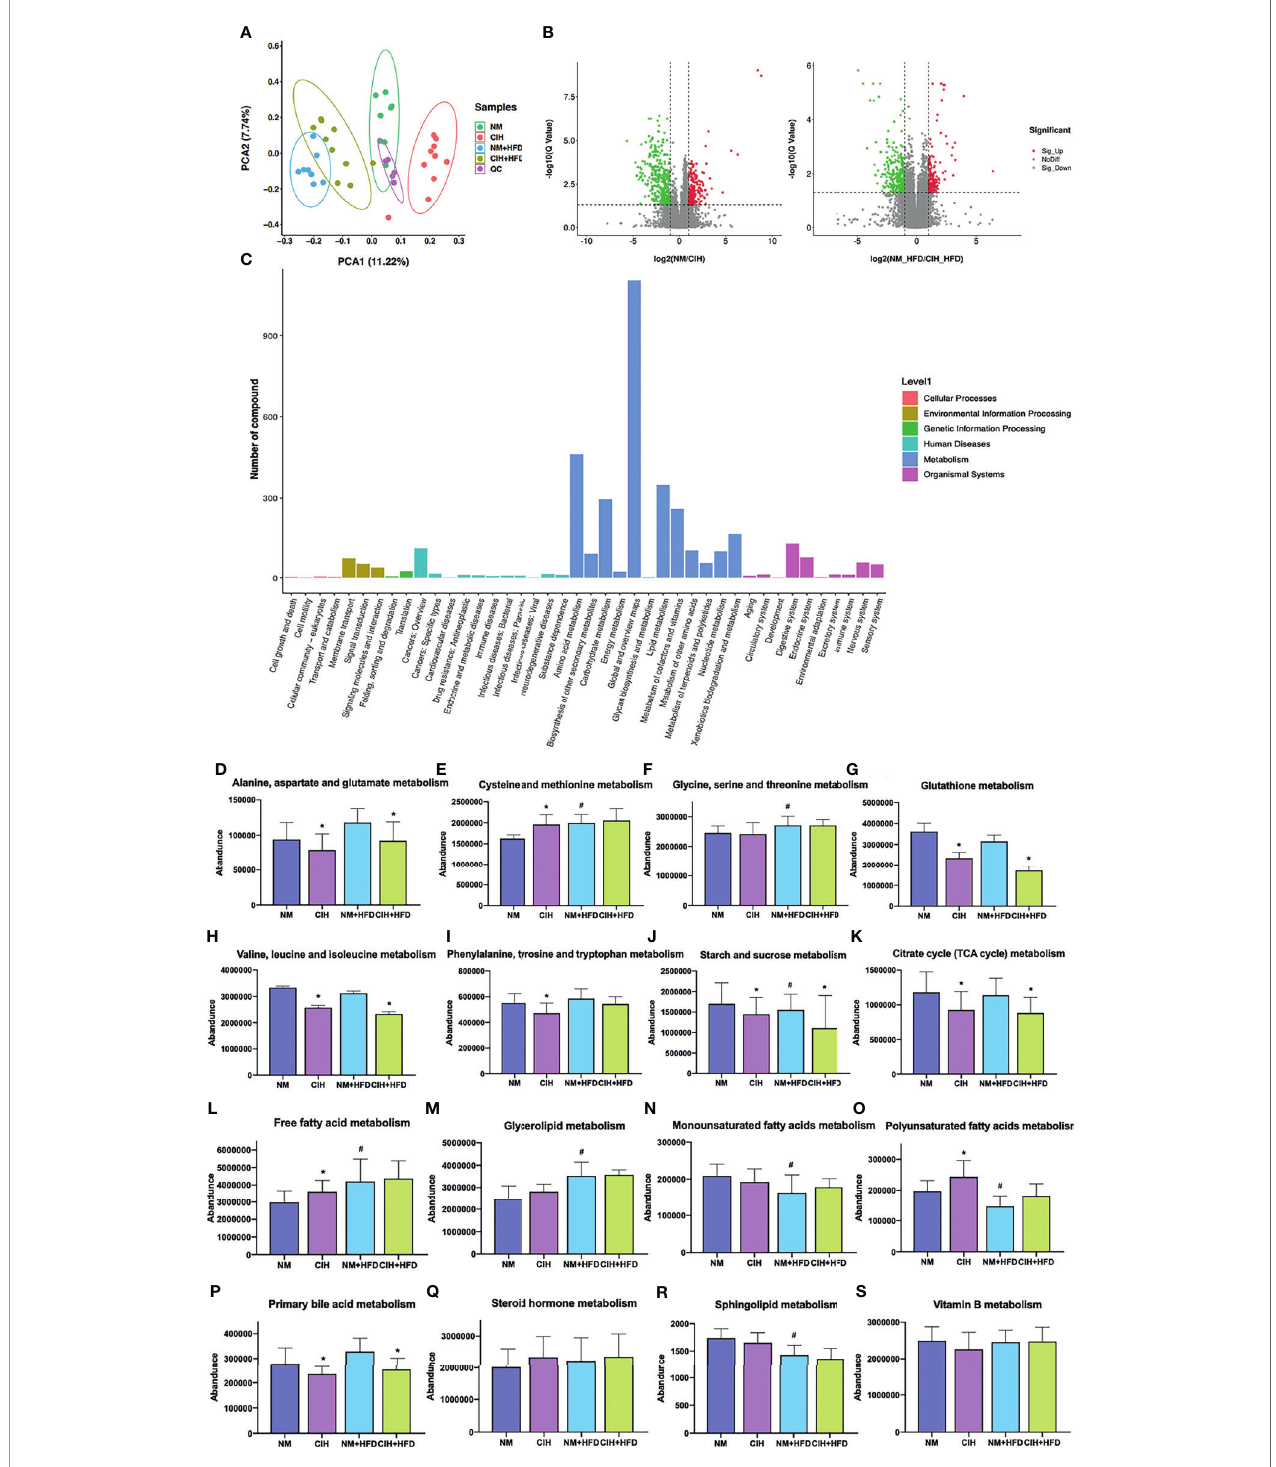
FIGURE 6 | Effects of CIH on the serum metabolome. (A) The PCA plot of metabolites generated by using the metabolite intensity from the NM (n = 8), CIH (n = 10), NM+HFD (n = 8), and CIH+HFD (n = 10) groups. (B) Volcano plots of metabolites with FDR < 0.05 and fold changes of > 4/3 or < 3/4 when comparing NM vs CIH, or comparing NM+HFD vs CIH+HFD. (C) Enrichment of activated pathways induced by alterations of metabolites in NM, CIH, NM+HFD and CIH+HFD groups. (D – S) The abundance of metabolite pathways from the NM, CIH, NM+HFD and CIH+HFD groups. Data are expressed as mean ± SEM. Group differences were assessed by using the Mann ‐ Whitney U test. *P < 0.05 when comparing NM vs CIH, or NM+HFD vs CIH+HFD, # P < 0.05 when comparing NM vs